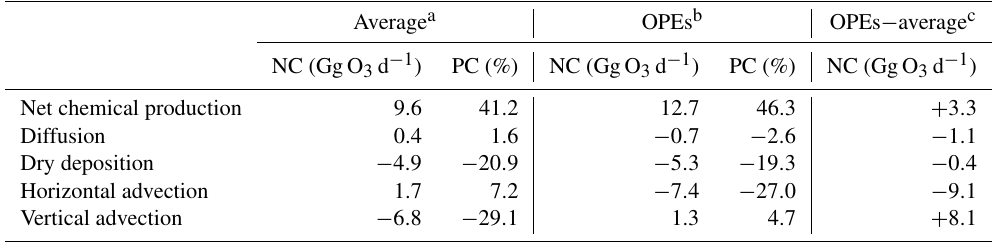
Table 1. Net changes (NC) in O 3 mass (GgO 3 d − 1 ) and percentage contributions (PC(%)) of different processes to O 3 in North